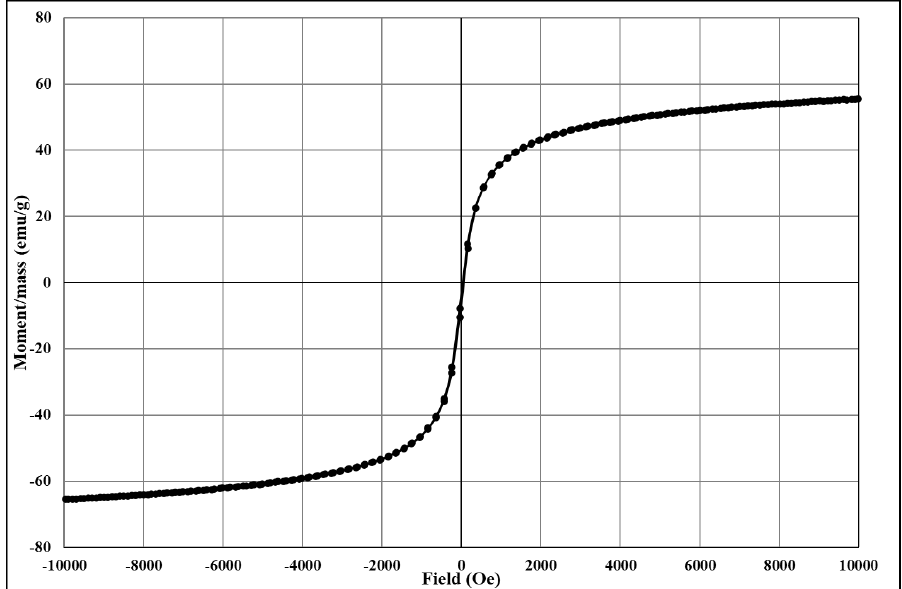
Figure 4. The magnetization/mass ratio for Fe 3 O 4 @citrate (reference sample).